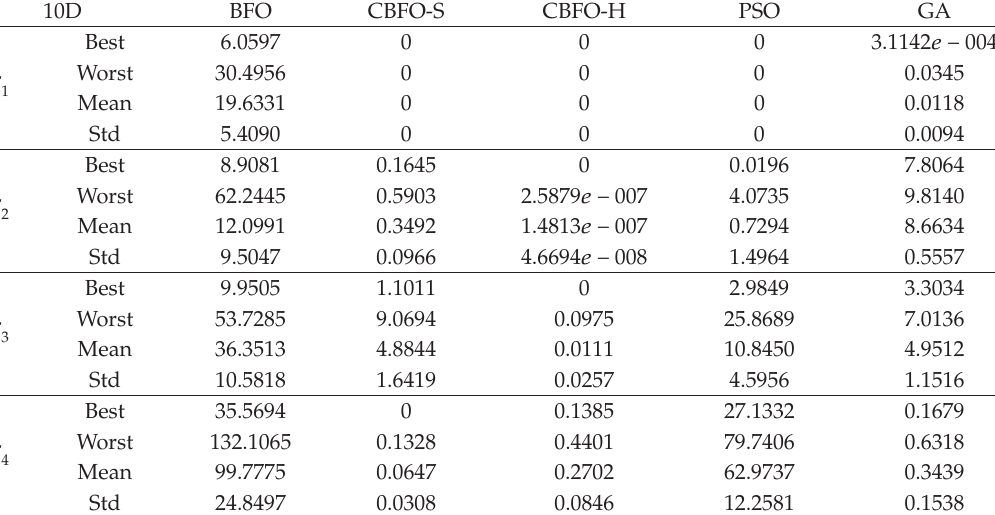
Table 3: Comparison among CBFO-H, BFO, PSO, and GA on 10-D